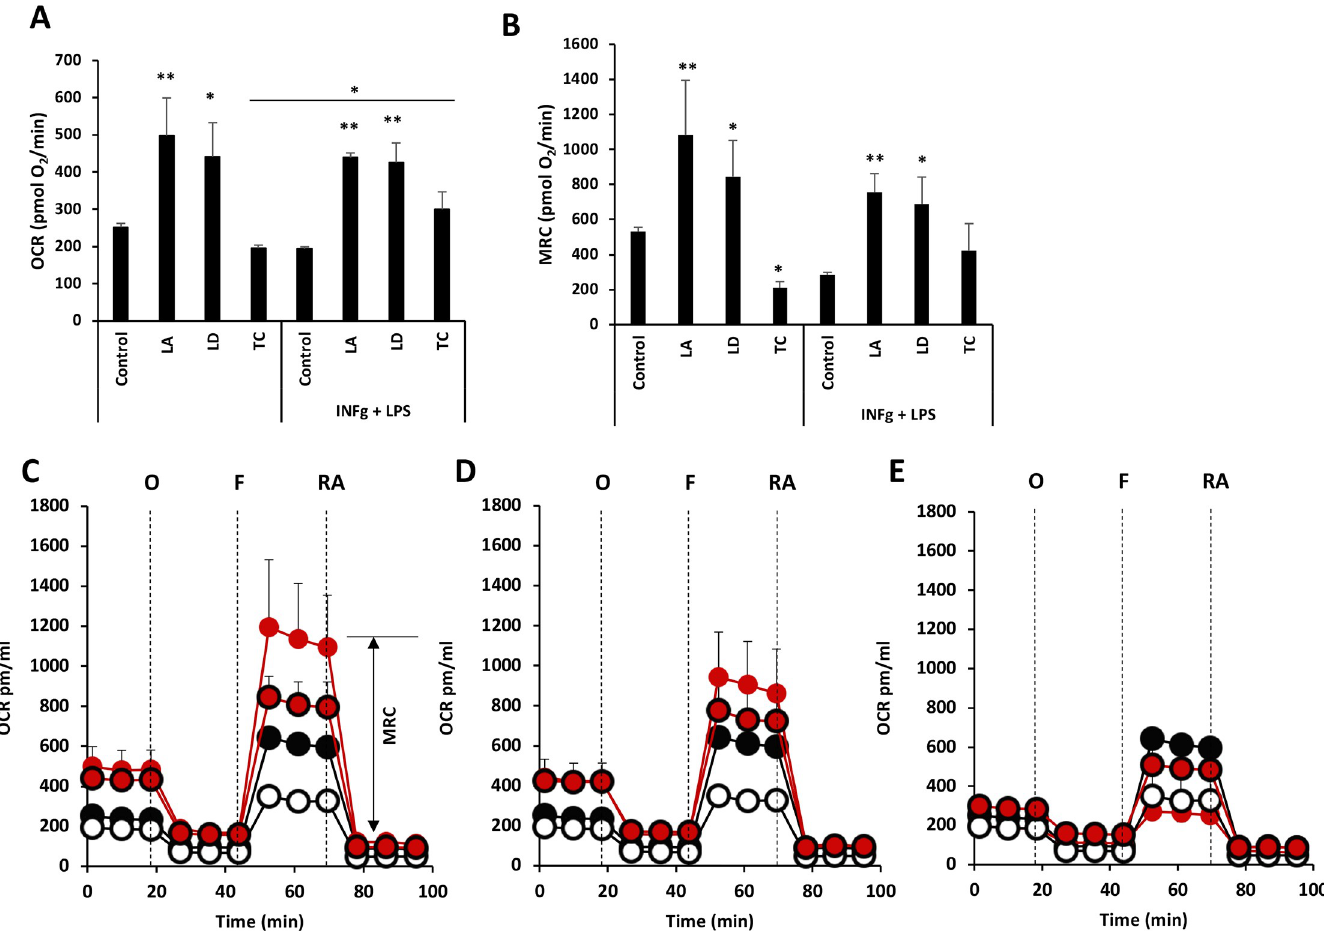
Fig 2. L . amazonensis and L . donovani , but not T . cruzi infection, increase basal and maximal respiratory capacity of human macrophages. Basal (A) and maximal (B) respiratory capacity of macrophages infected with the indicated parasites for 18 h and treated with or not with IFN- γ +LPS 6 h before the starting Seahorse determinations. (C-E) Real-time changes in OCR of macrophages infected with L . amazonensis (C), L . donovani (D) or T . cruzi (E) after treatment with oligomycin (O) (1 μ M), FCCP (F) (1 μ M), and rotenone and antimycin A (RA) (0.5 μ M). Parasite-infected macrophages are shown in red circles and IFN- γ +LPS stimulation in bold edges. Maximal respiratory capacity (MRC; double-headed arrow) is shown in (C). Average and standard deviation of triplicates from one experiment is shown. � p < 0.05, �� p < 0.01 and ��� p < 0.001 by one-way ANOVA compared with control or IFN- γ +LPS control. Lines indicate ANOVA comparison of IFN- γ +LPS treated cells to unstimulated ones. Independent stars indicate ANOVA comparison of cells infected with each parasite to control uninfected cells. One representative experiment out of 2 is shown.